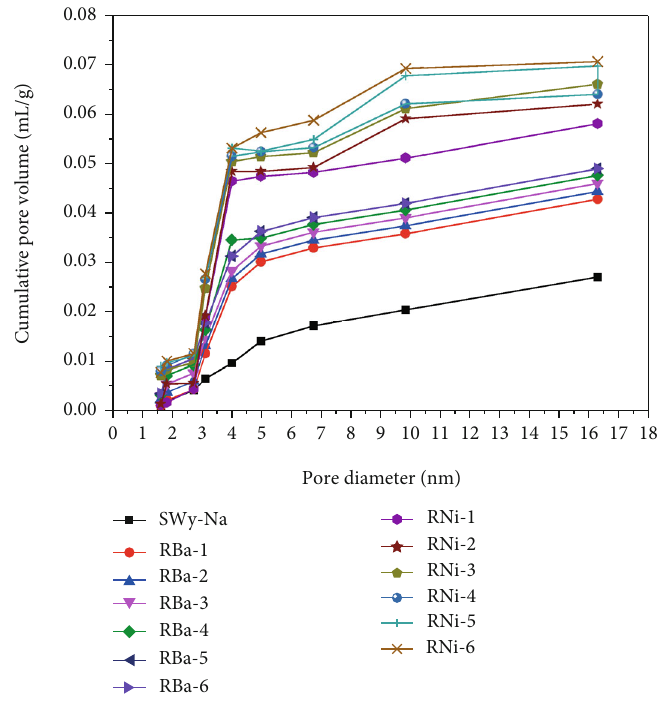
Figure 8: The pore size distribution (PSD) curve for the di ff erent studied samples ( V − r ).